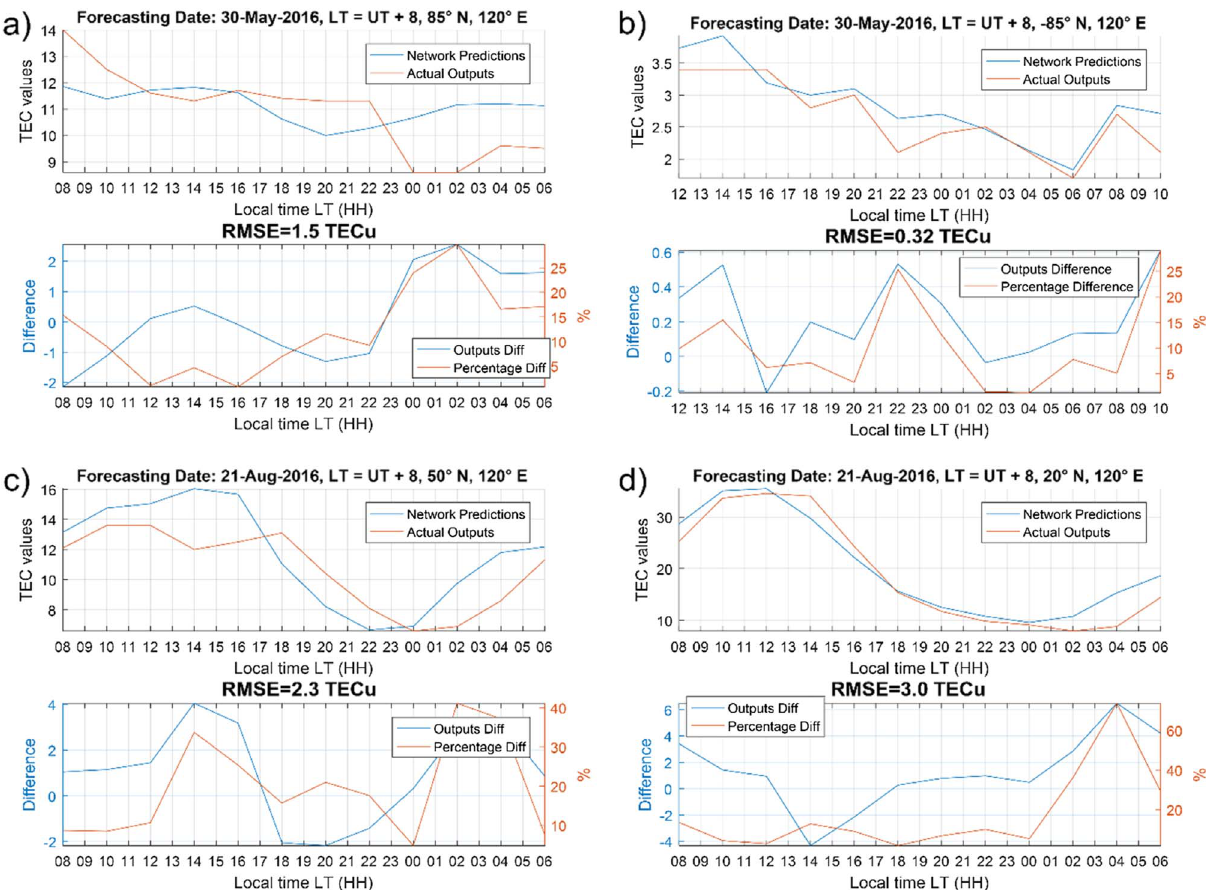
Fig. 5. Examples of TEC forecasting as a function of the local time at high-latitude in the northern (a) and southern (b) hemispheres, at mid- latitude (c) and at low-latitude (d). In each panel, actual (orange) and forecasted (blue) TEC are reported in the top plot, while absolute (blue) and relative (orange) difference between forecasted and actual TEC are reported in the bottom plot.